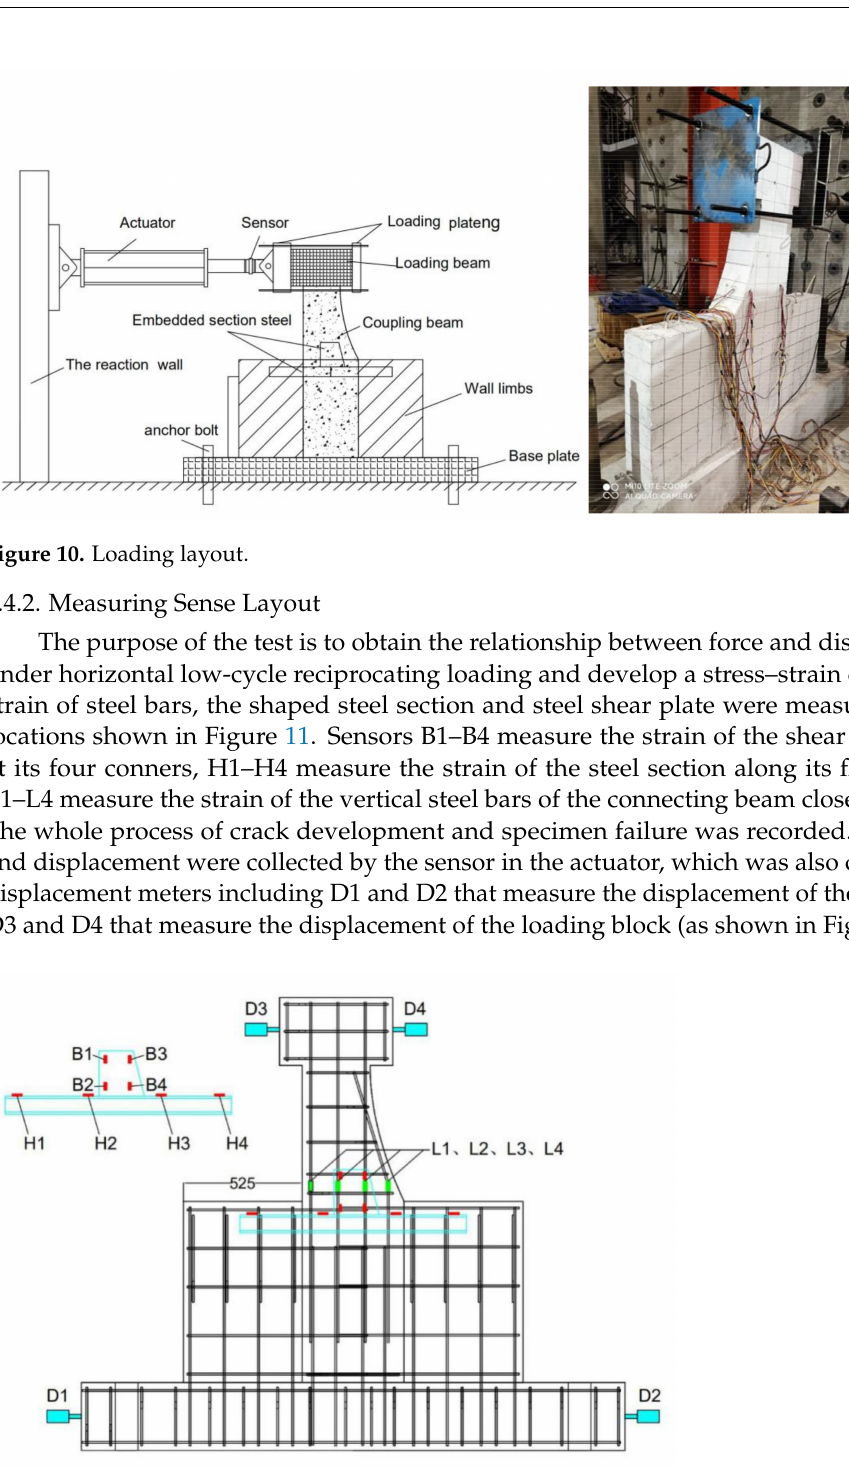
Figure 11. Layout of the measuring